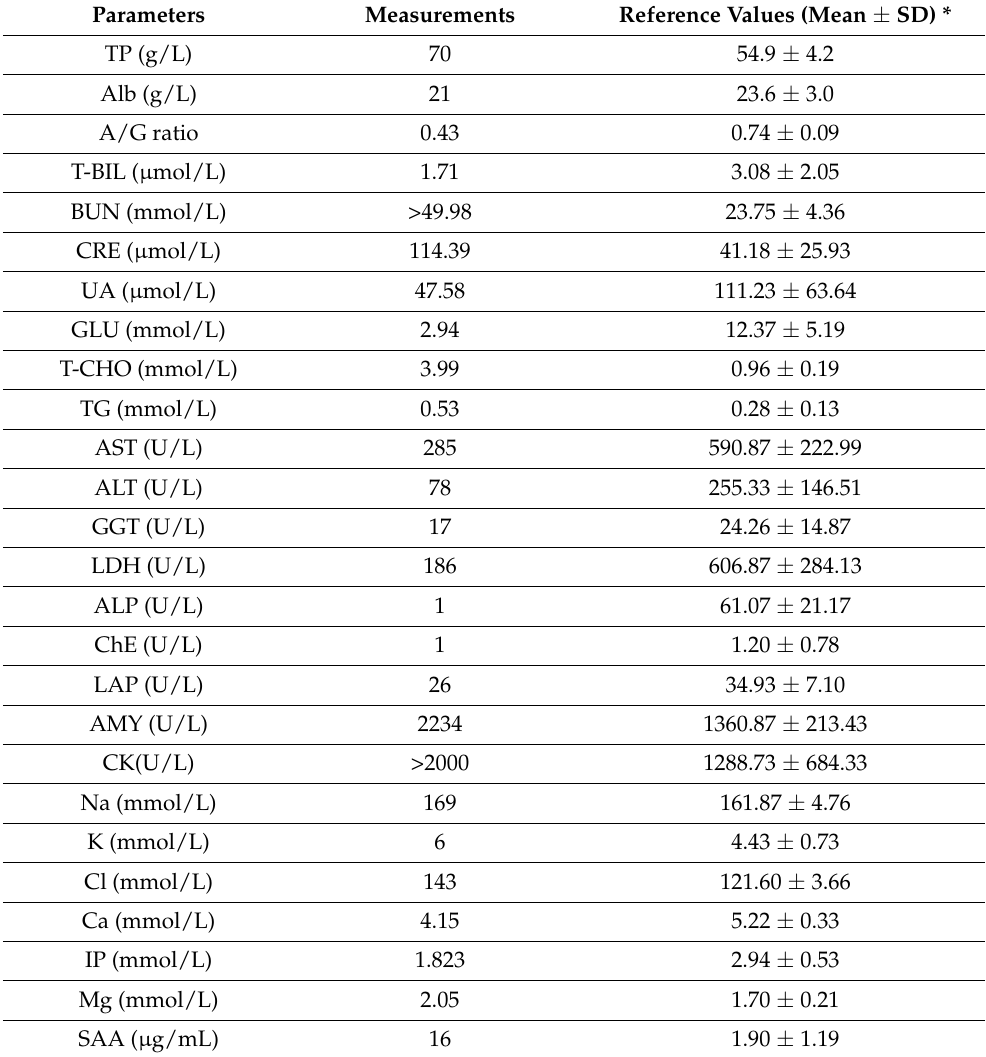
Table 2. Serum biochemical findings in Suncus murinus with polycystic